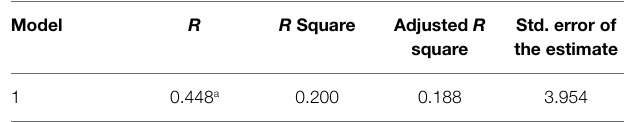
TABLE 5 | Coefficient of determination test (adjusted R2)